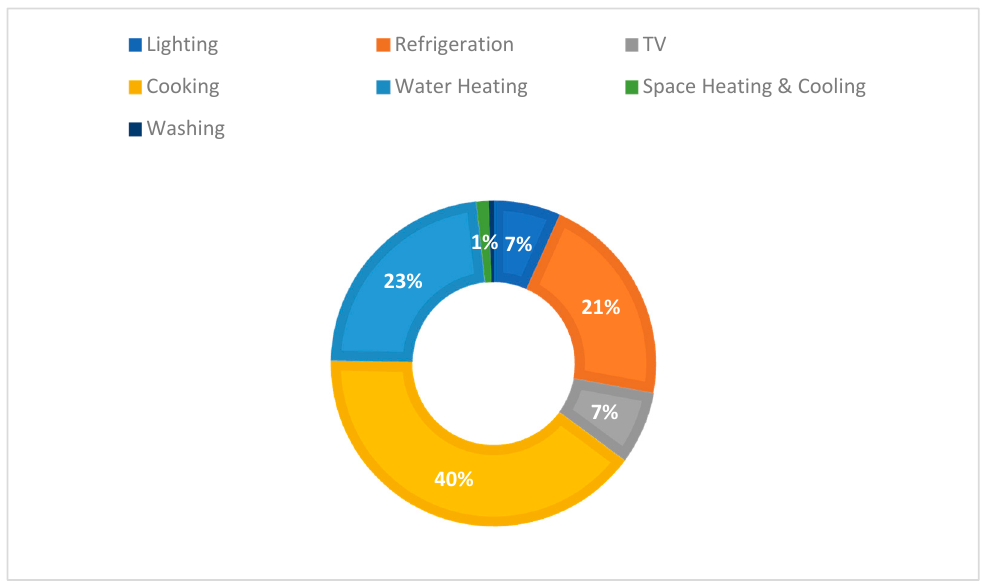
Figure 2. Actual total annual appliance energy consumption by end-use.